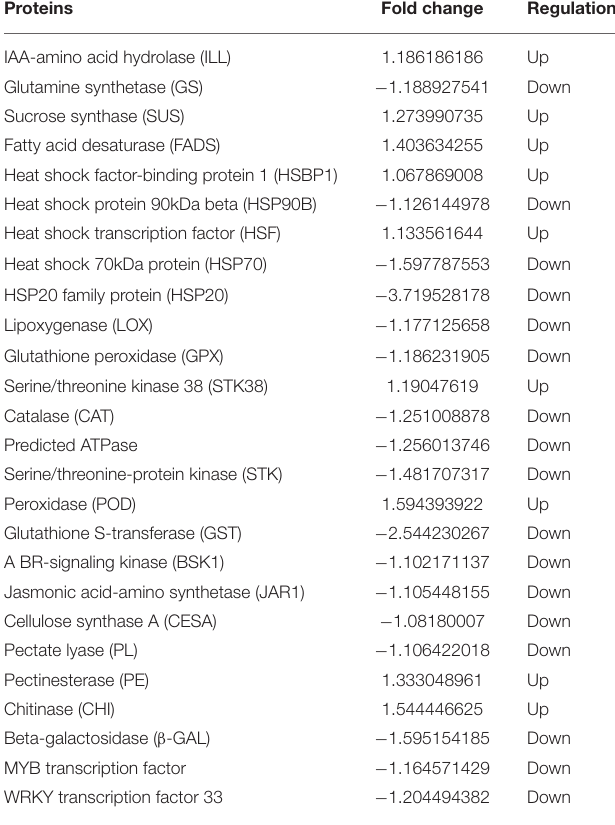
TABLE 4 | Regulation and change fold of differentially expressed proteins involved in CI process of BR 8 vs. CK 8 day group. Proteins